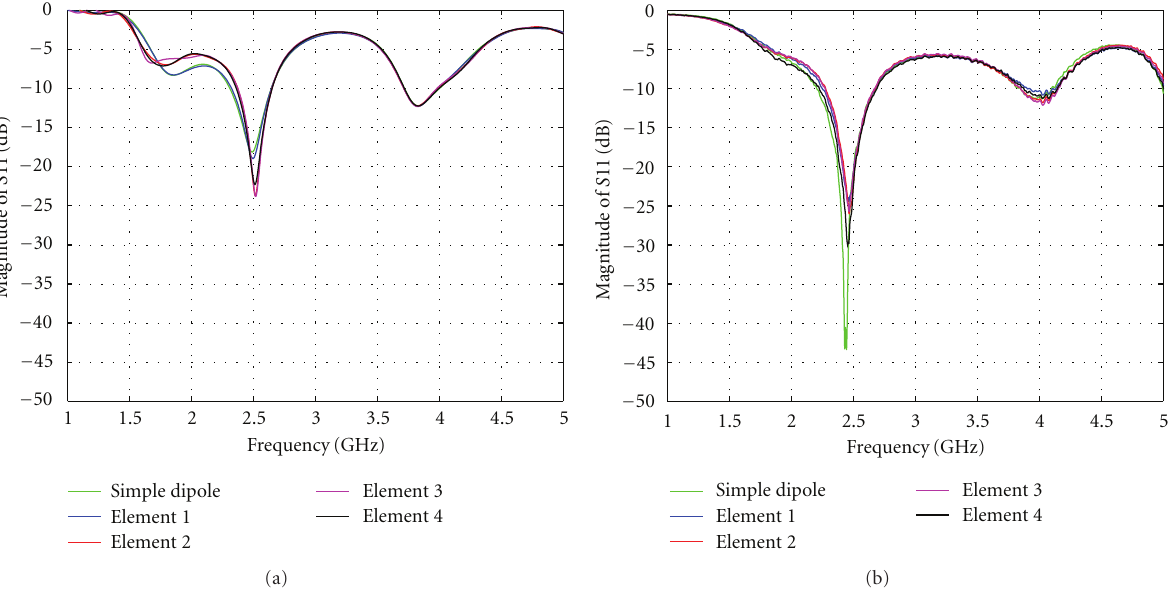
Figure 9: Magnitude of S 11 parameter on single dipole and elements on ULA array structures without reflector: (a) simulated and (b)